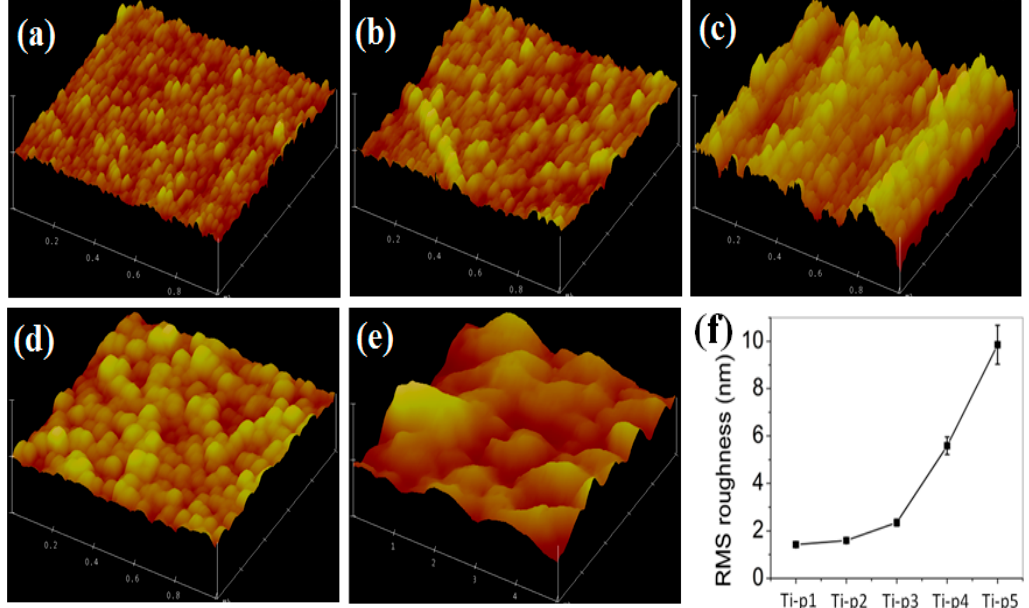
Figure 3. Atomic Force Microscope (AFM) images of polished-titanium substrates with different torching time. (The x-y axis scale of AFM images were 1 µ m by 1 µ m for ( a – d ) and 5 µ m by 5 µ m for ( e ). The z axis scale of AFM images were 30 nm for ( a – c ) and 100 nm for ( d ) and ( e )); ( a ) Ti-p1, ( b ) Ti-p2, ( c ) Ti-p3, ( d ) Ti-p4 and ( e ) Ti-p5. ( f ) RMS roughness of ( a – e ).